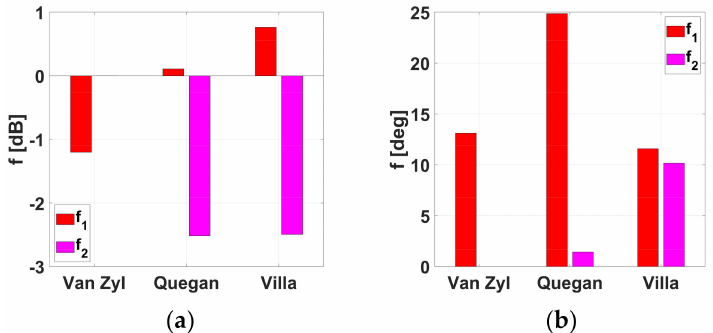
Figure 9. ( a ) Amplitude and ( b ) phase estimates of the channel imbalances by the Van Zyl method ( f ), by the Quegan method ( f 1,2 ), and by the Villa method ( f 1,2